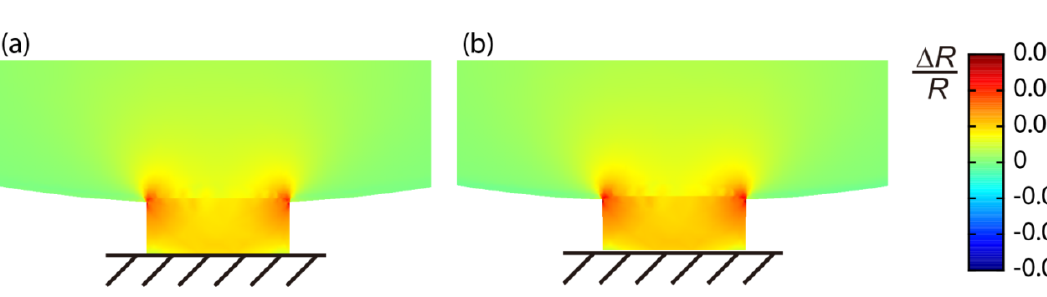
Figure 5. FEA of the distribution of Δ R / R on the R ( a ) 250 nm and ( b ) 150 nm below the surface,